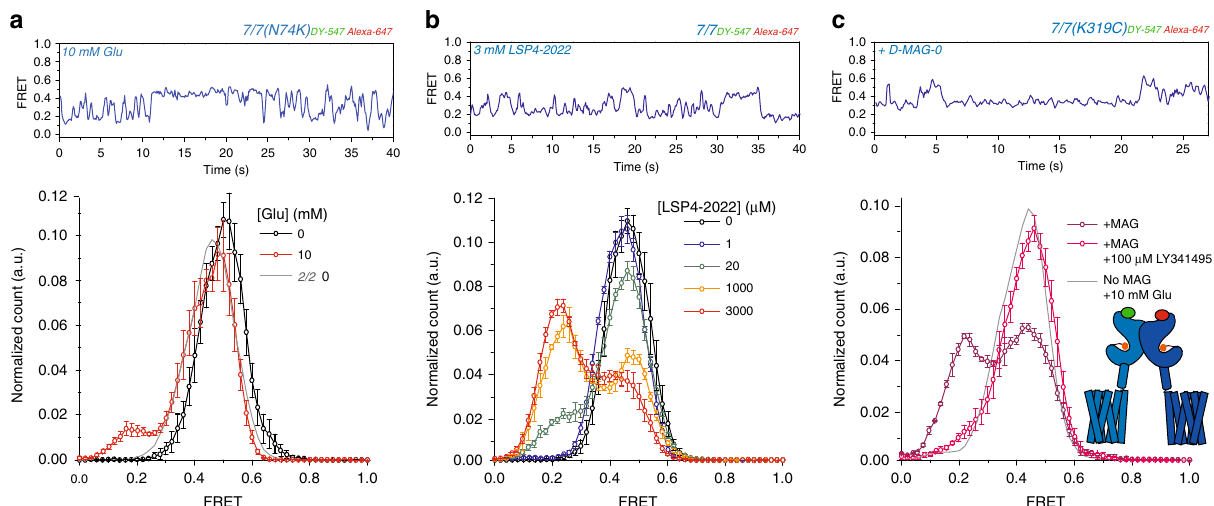
Fig. 2 Increasing mGluR7 ef fi cacy. a – c Representative smFRET traces (top) and smFRET histograms (bottom) of homodimers of SNAP-mGluR7(N74K) (0 Glu: 4 movies, 124 moleucles, 10 mM Glu: 4 movies, 140 molecules, s.e.m. error bars) compared to SNAP-mGluR2 in glutamate ( a ); SNAP-mGluR7 in LSP4-2022 (0: 4 movies, 145 molecules, 1 μ M: 5 movies, 197 molecules, 20 μ M: 5 movies, 128 molecules, 1 mM: 5 movies, 122 molecules, 3 mM LSP4: 6 movies, 206 molecules, s.e.m. error bars) ( b ); and SNAP-mGluR7(K319C) conjugated to D-MAG-0 in the trans con fi guration (8 movies, 230 molecules, s. e.m error bars), in the presence of 100 μ M LY341495, and unconjugated SNAP-mGluR7(K319C) (6 movies, 256 molecules, s.e.m. error bars) ( c , and cartoon insert). Donor (BG-DY-547) and acceptor (BG-Alexa 647) dyes imaged at 10